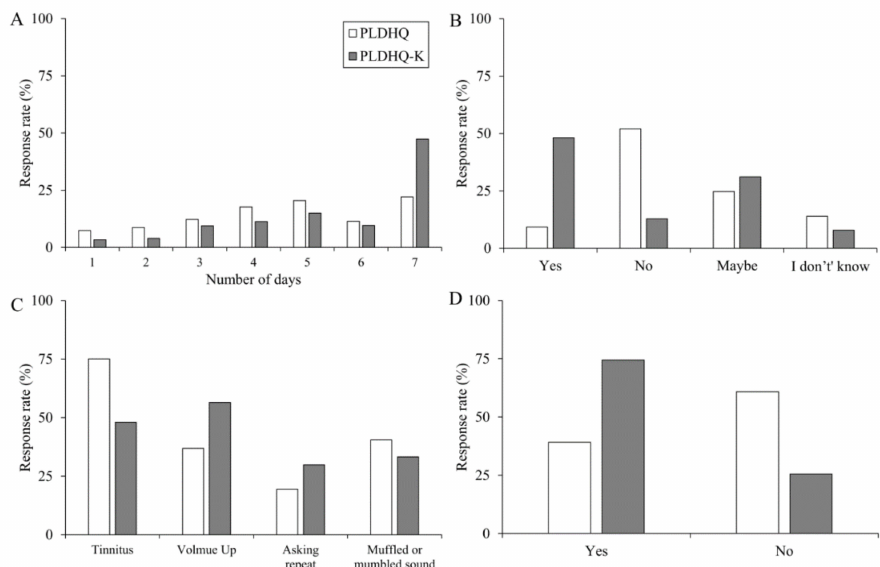
Figure 1. Data comparison of the original Personal Listening Device and Hearing Questionnaire (PLDHQ) and the current Korean version (PLDHQ-K): ( A ) How many days do you use your PLDs in a week? (Q37), ( B ) If you already have a hearing loss, do you think that your use of PLDs is one of its causes? (Q65), ( C ) Questions regarding signs of hearing loss (Q9, 11, 13, and 15), ( D ) Do you want to study more about the potential hearing loss associated with using PLDs?